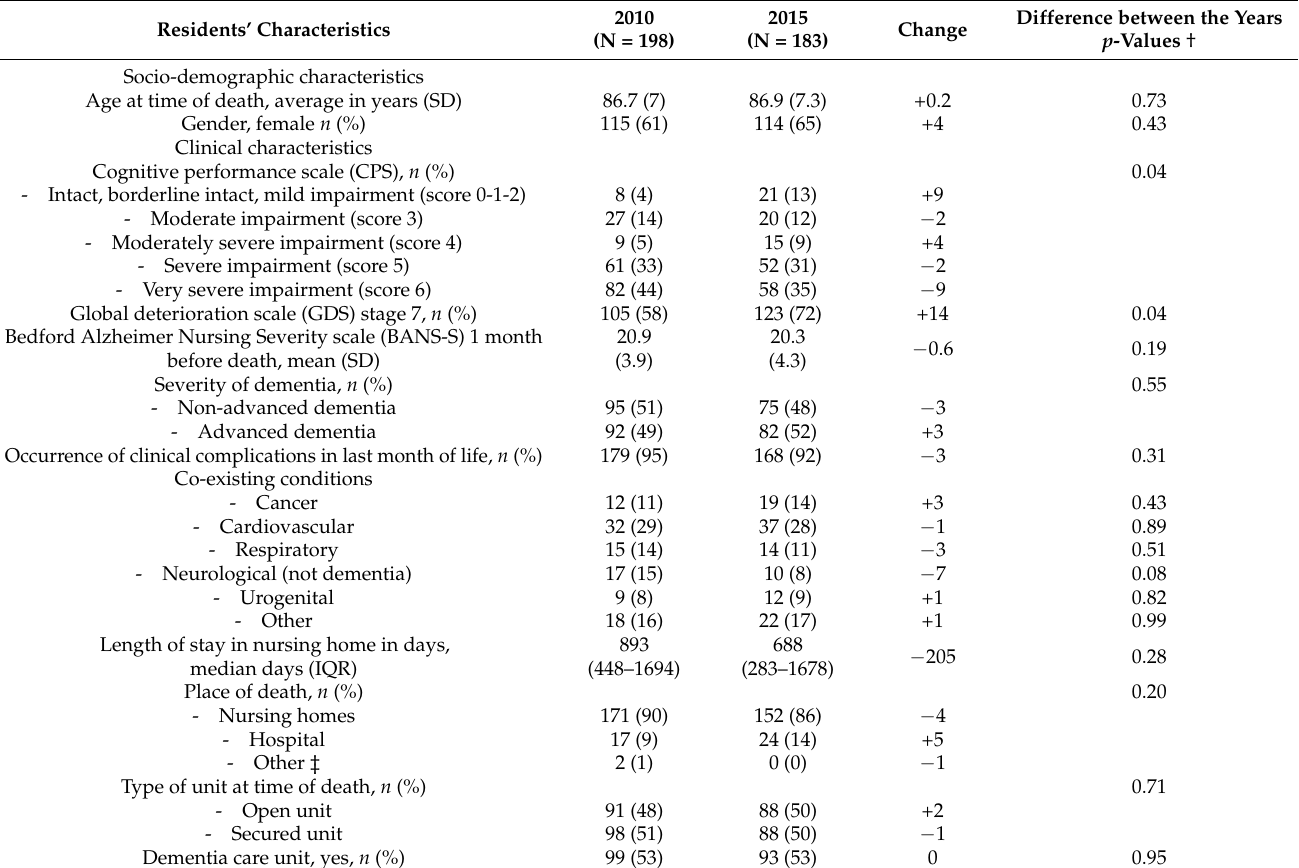
Table 1. Comparing residents’ characteristics between 2010 and